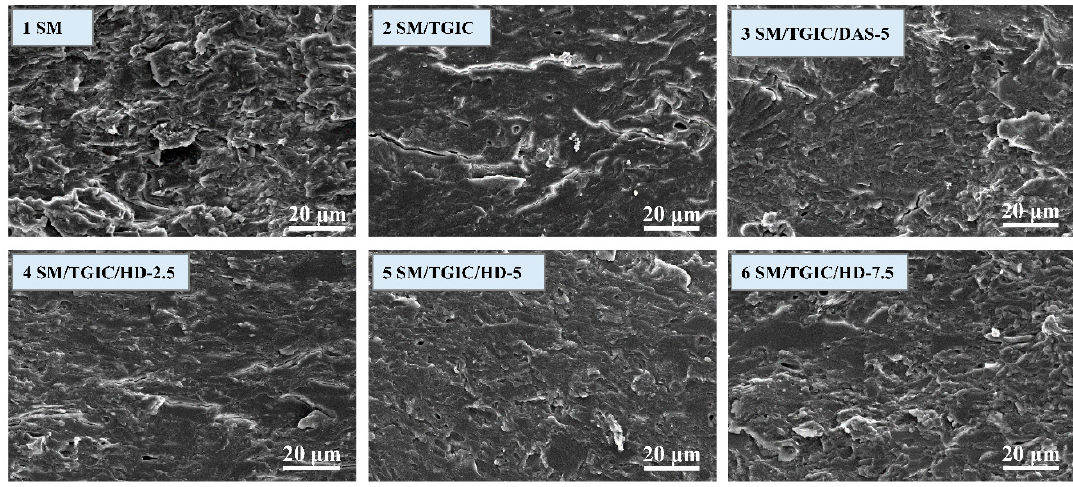
Figure 6. SEM images of the adhesives’ fracture surfaces.